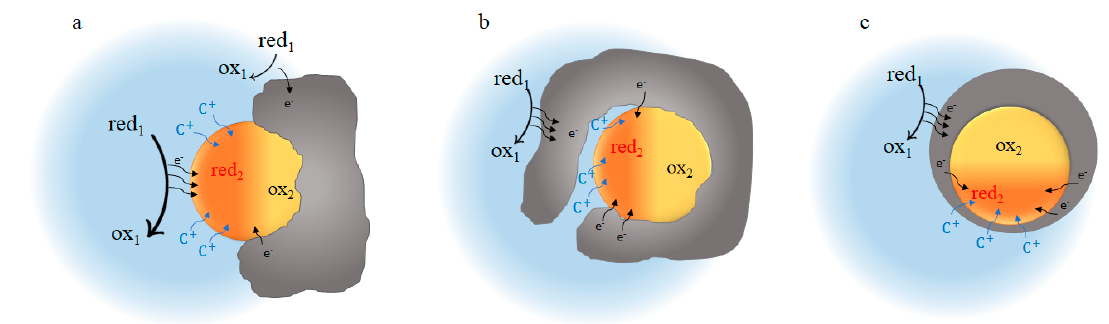
Figure 7. Possible pathways for charge transfer between redox electrolyte red 1 /ox 1 and redox solid red 2 /ox 2 : ( a ) Direct chemical charge transfer; ( b ) Electron transfer through conductive additive; ( c ) Charge transfer in an enclosed system, where also the cation has to go through a carbon material.